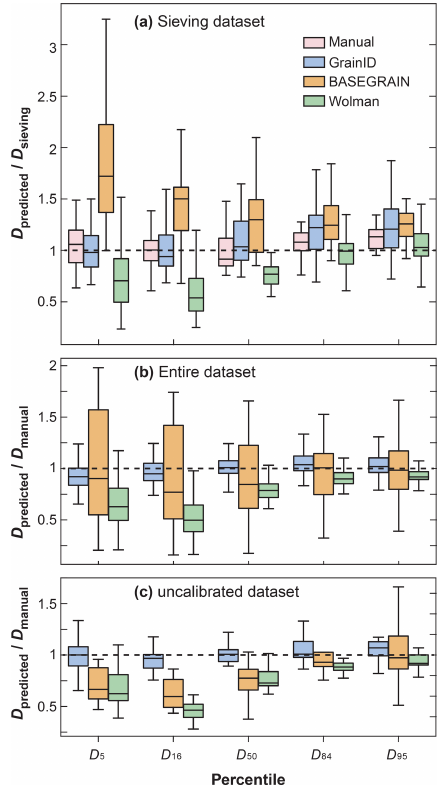
Figure 6. Performance comparison for different methods. (a) D predicted /D sieving shown for grain percentiles D i of the man- ual labeling, GrainID, BASEGRAIN and Wolman methods (re- ferred to as G, B and W methods, respectively) for a flume sandy- gravel bed; (b) D predicted /D manual shown for D i of G, B and W methods for the entire datasets; and (c) D predicted /D manual shown for D i of G, B and W methods for uncalibrated rivers with drone